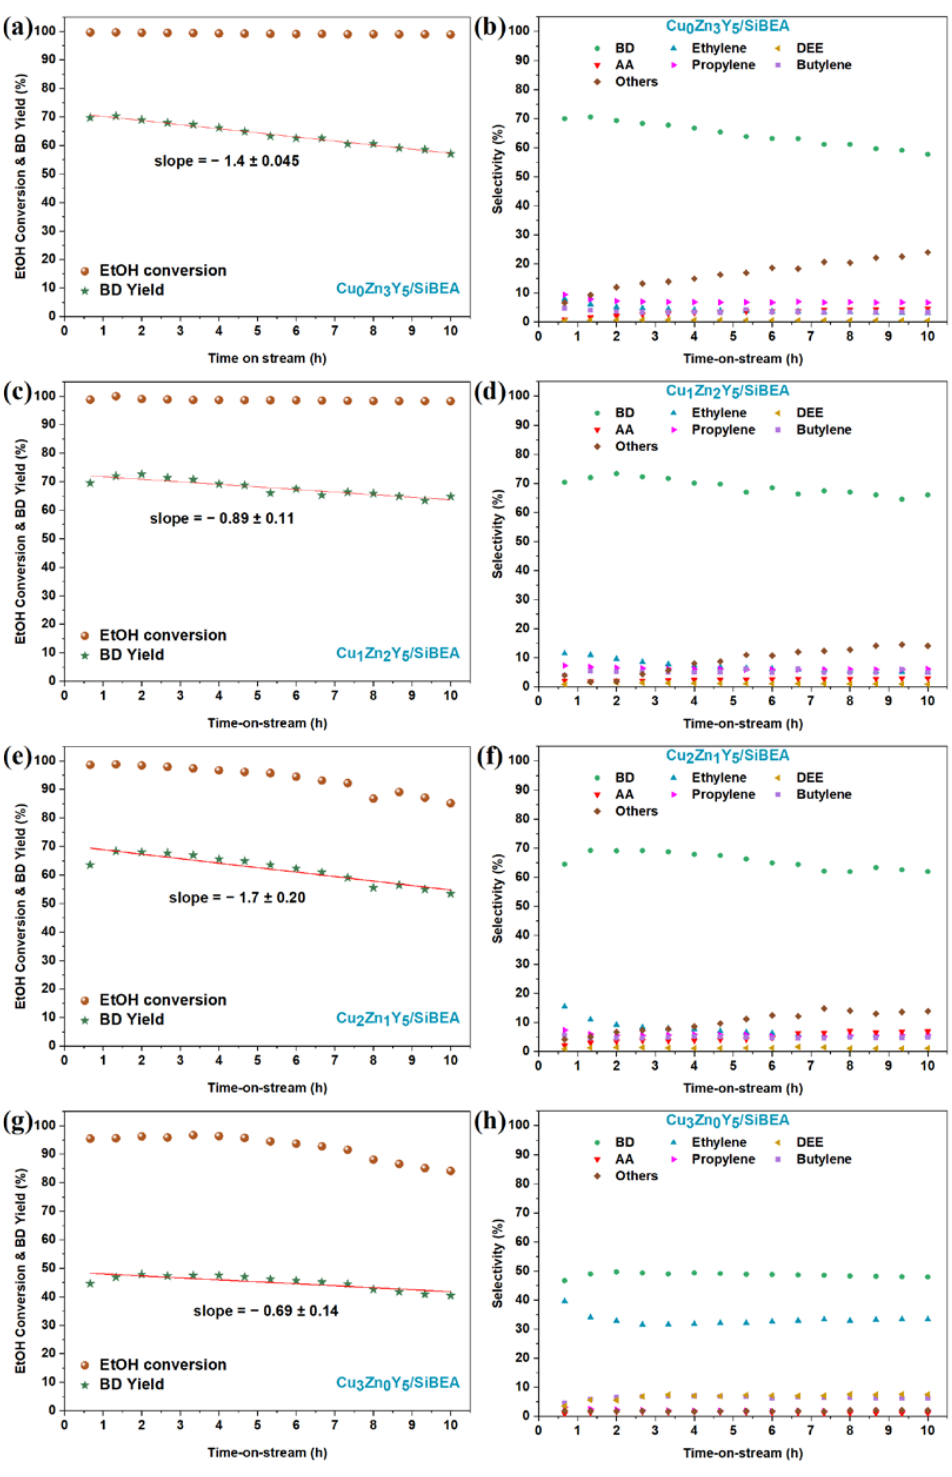
Figure 6. ( a ) EtOH conversion, BD yield, and ( b ) product selectivity over Cu 0 Zn 3 Y 5 /SiBEA catalyst; ( c ) EtOH conversion, BD yield, and ( d ) product selectivity over Cu 1 Zn 2 Y 5 /SiBEA catalyst; ( e ) EtOH conversion, BD yield, and ( f ) product selectivity over Cu 2 Zn 1 Y 5 /SiBEA catalyst; ( g ) EtOH conversion, BD yield, and ( h ) product selectivity over Cu 3 Zn 0 Y 5 /SiBEA catalyst. ETB reaction conditions: T = 375 ◦ C, WHSV = 1 · h − 1